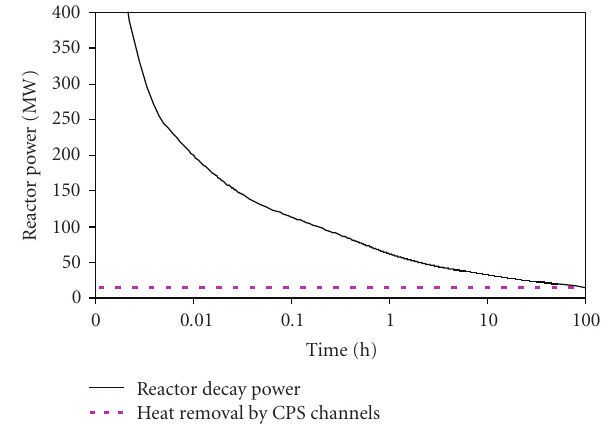
Figure 11: Comparison of reactor decay heat with capacity of heat removal from core by CPS cooling circuit in station blackout